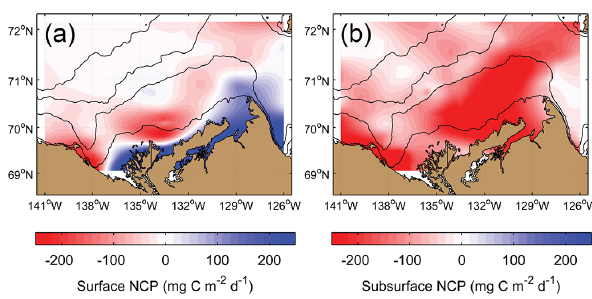
Figure 10. Maps of net community production (NCP) in the (a) surface and (b) subsurface layer of the study area as based on total gross primary production minus total community respiration. The subsurface NCP accounts for the respiration flux from the benthos (over the shelf only, i.e., until the 100m isobath). The mean mixed- layer depth delimits the boundary between the surface and subsur- face layer; and the subsurface layer extends down to 100m maxi- mum. Bathymetric contours are 20, 100, 1000, and